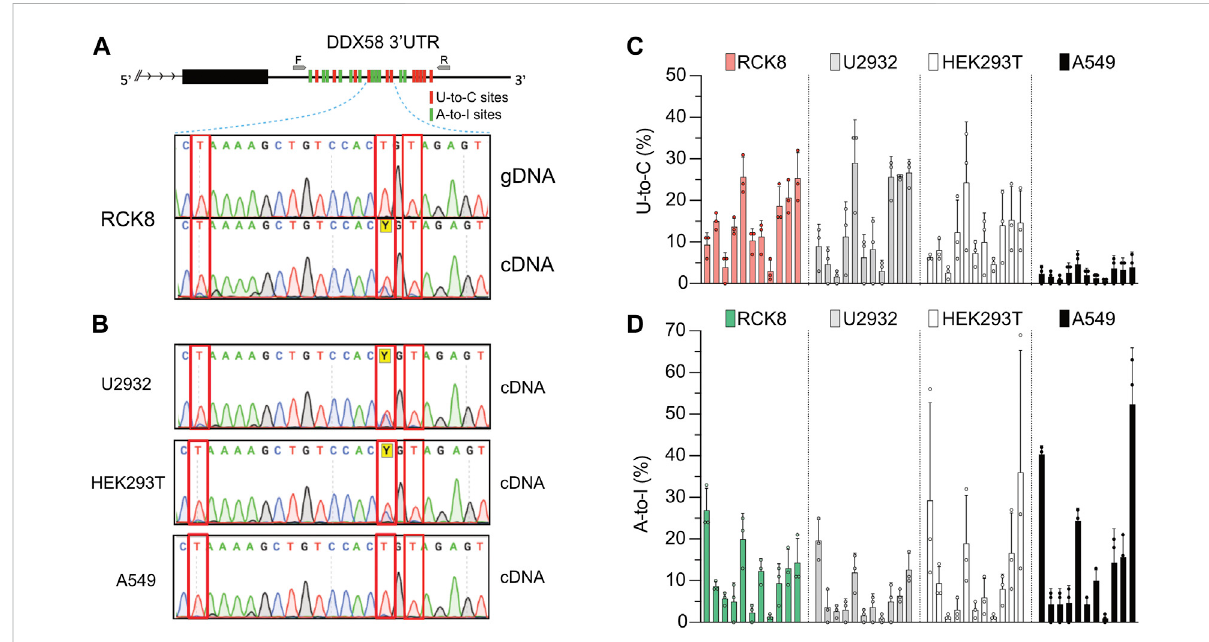
FIGURE 1 A persistent U-to-C base change in DDX58 cDNA. (A) Upper: schematic representing the identi fi cation of 11 U-to-C (red bars) and 11 A-to-I (green bars) base changes within the 3 ′ UTR of DDX58 in the B cell line RCK8. Primers used for PCR ampli fi cation are indicated as small grey arrows. Lower: representative image of Sanger traces showing that U-to-C base changes (inside the red rectangles) are only present in cDNA and not in genomic DNA (gDNA). (B) These RNA base changes are present at the same in other cell lines. (C,D) Quanti fi cation of the 11 U-to-C (C) and 11 A-to-I (D) sites within different cell lines. Quanti fi cation was performed directly from Sanger traces using MultiEditR (Kluesner et al., 2021). Center = mean and error bars = standard deviation, N =